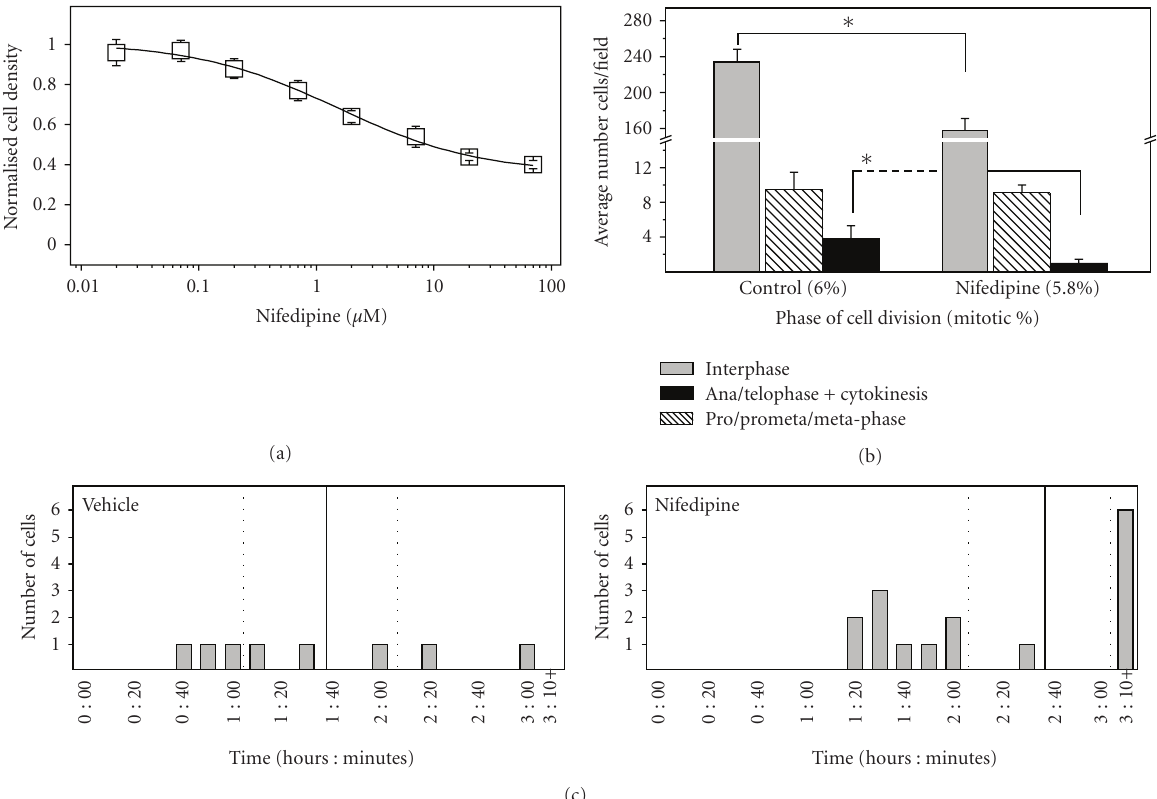
Figure 2: Nifedipine attenuates AtT-20 Cell density . (a) Cell viability . Incubation with the DHP CaV antagonist, nifedipine, results in a dose-dependent decrease in AtT-20 cell number using the colorimetric MTS assay for cell viability. The half maximal dose for this e ff ect is 1 . 5 ± 0 . 3 μ M nifedipine. Graph shows normalized data from 3 experiments. (b) Cell proliferation and mitotic stages. Graph shows mean number of cells ± SE for at least 5 fields ( ≥ 800 total cells counted for Day 3 for each condition). There is a significant decrease in the total number of cells counted between vehicle control and nifedipine-treated cells ( ∗ P < . 05). There is also a parallel decrease in later phases of mitosis (A/T/C) ( ∗ P < . 05). Nifedipine = 6 μ M; Vehicle = DMSO from which nifedipine is diluted from 10mM stock solution. (c) Time for transition through mitosis. Measurements for individual AtT-20 cells using time-lapse microscopy. The time from prophase to cytokinesis is depicted for both control (Vehicle) and Nifedipine-treated cells. The mean time for completion of mitosis is indicated by the bold line with the dotted lines representing 2 S.D. from the mean. Nifedipine treated cells show a shift in mean time to complete mitosis as well as an increased number of cells that do not complete mitosis (block) within the 2 S.D. time limit compared to control